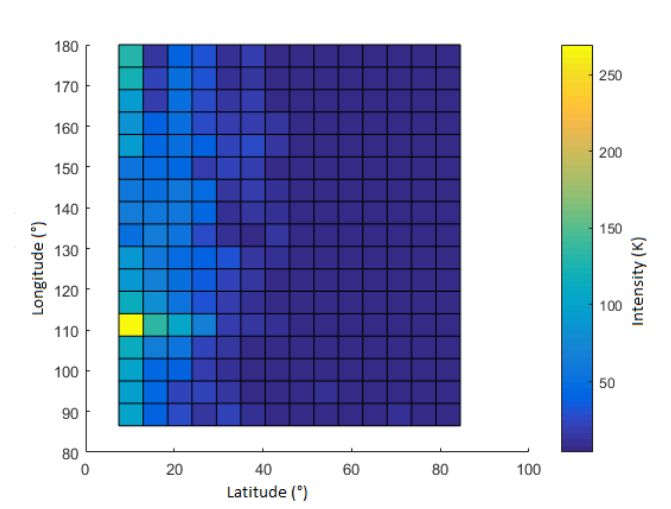
Figure 3. Peak-intensity map of HI 21-cm lines covering an 80 ◦